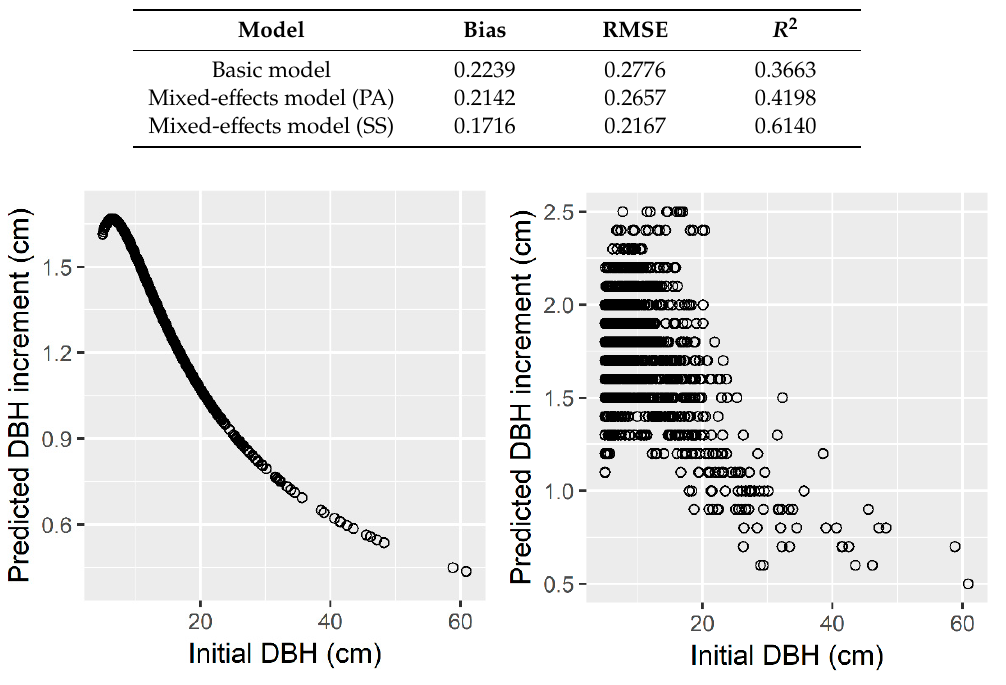
Table 6. The lack-of-fit statistics of model validation using the basic model and mixed-e ff ects model.